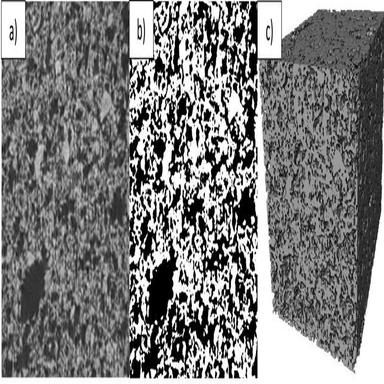
One of obtained grayscale images a), binarized and filtered image b), and final 3D image of material's microstructure c).